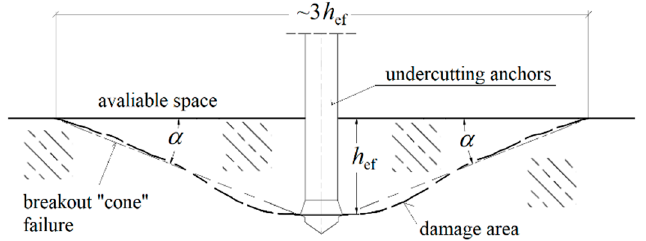
Figure 1. Breakout “cone” failure in rock materials ( h ef —effective anchoring depth, α —the angle of the cone of destruction of the medium).